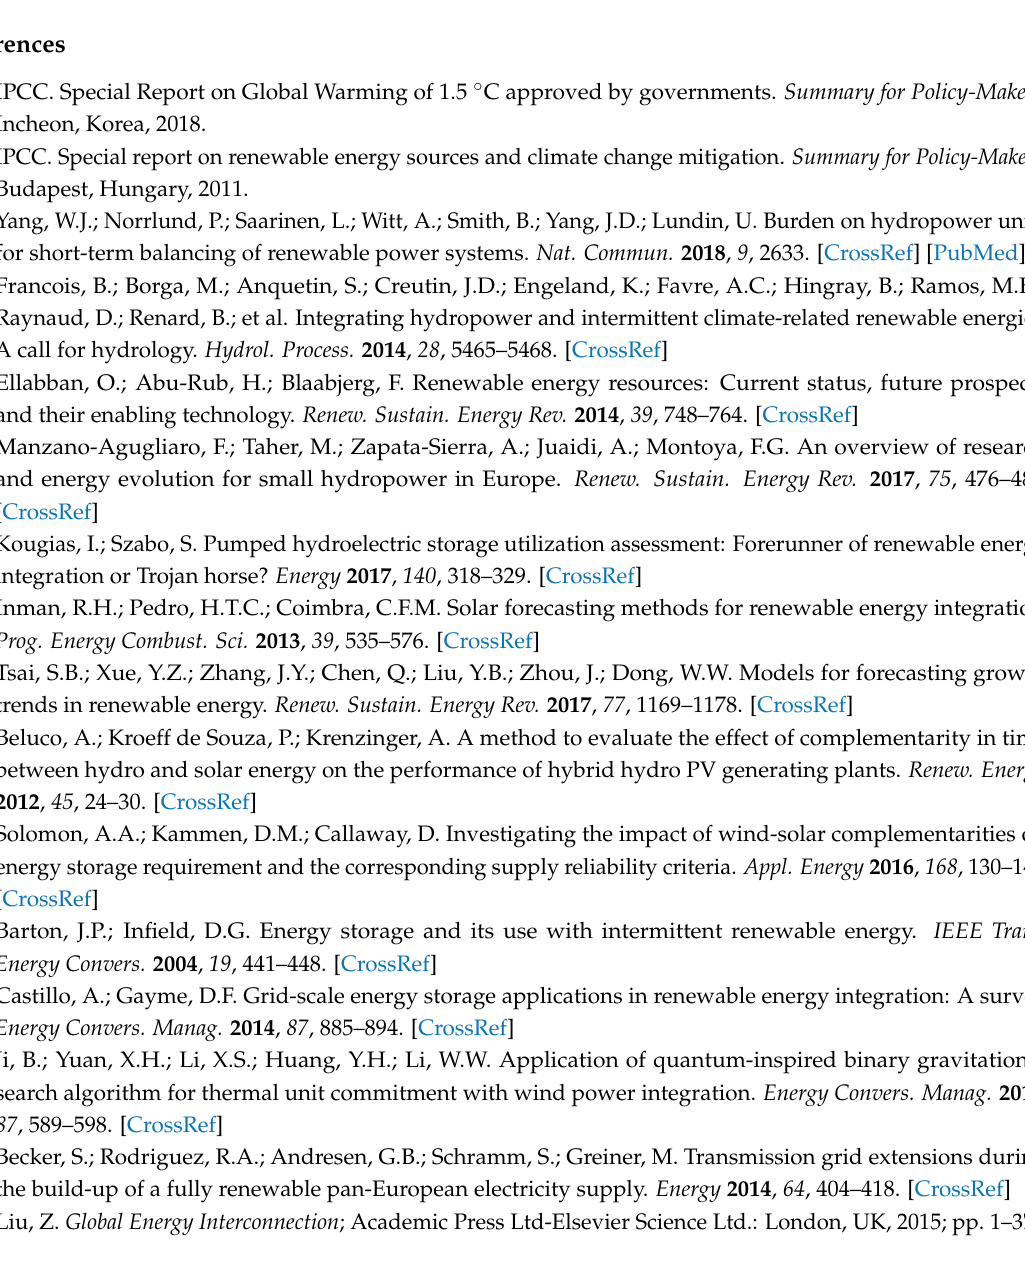
Figure A6. Operation process of SHP3 in County